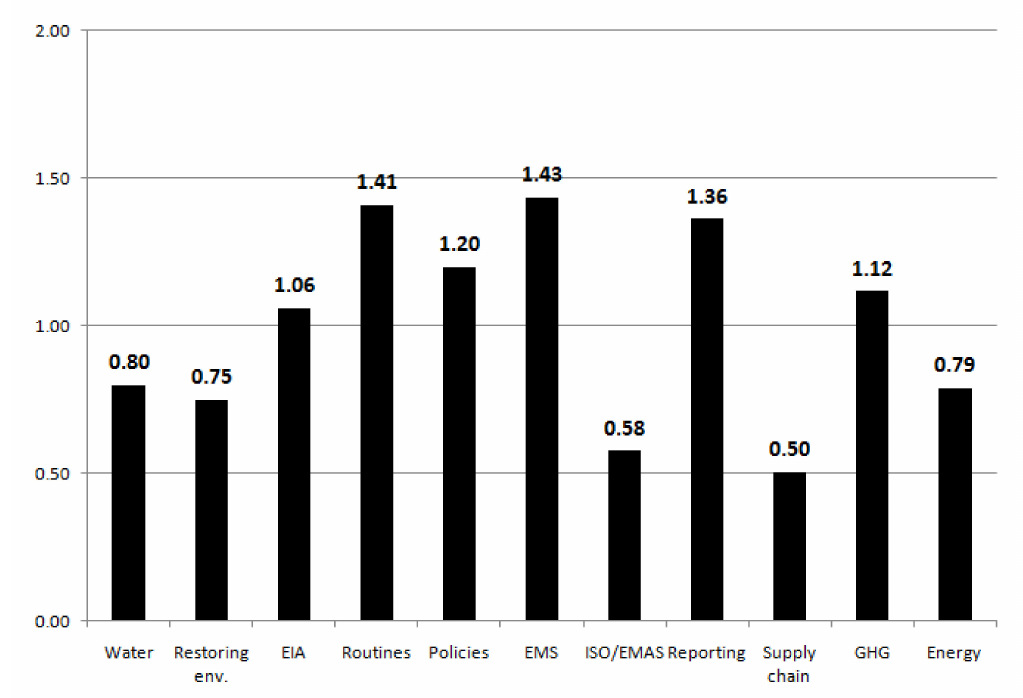
Figure 5. Indicators of CSR in energy